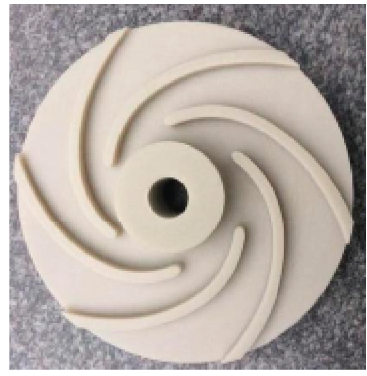
Figure 20: Picture of lining plastic